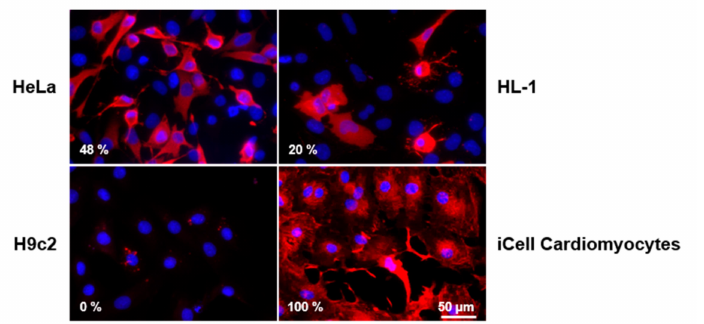
Figure 3. Immunofluorescence analysis of VP1 protein localization in different CVB3-infected cell lines. Cells were infected with MOI 10 and analyzed after eight hours. The percentage of VP1 positively stained cells is indicated in the left lower corner,